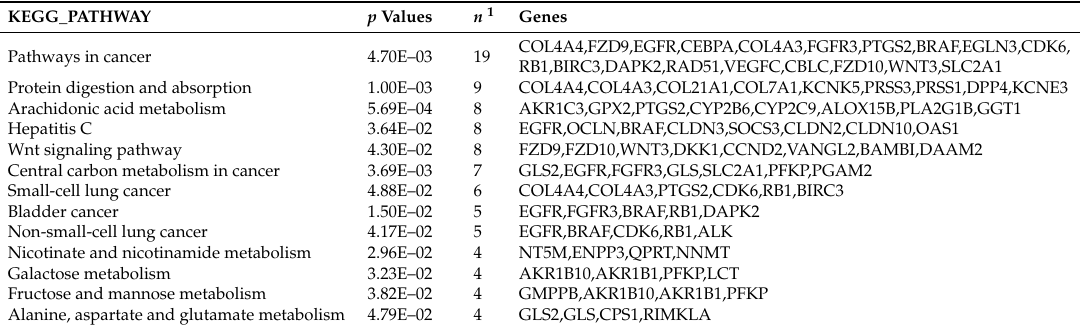
Table 5. Biologic pathways enriched by 431 differentially expressed mRNAs in EGFR -mutated compared to EGFR wild-type lung